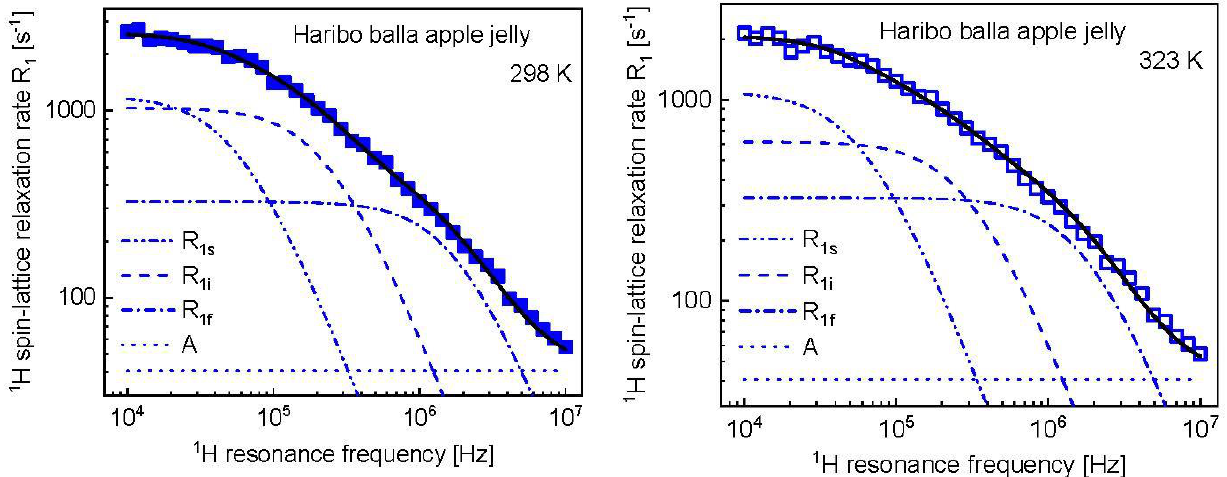
Figure A1. 1 H spin-lattice relaxation data for Haribo bara apply jelly at 298 K ( left ) and 323 K ( right ) reproduced in terms of the model described in the theory. The fit ( 𝑅 1 ) shown as a black solid line has been decomposed into relaxation contributions associated with slow, intermediate and fast dynamics, 𝑅 1𝑠 , 𝑅 1𝑖 and 𝑅 1𝑓 , respectively. The frequency independent term, 𝐴 , is also indicated.